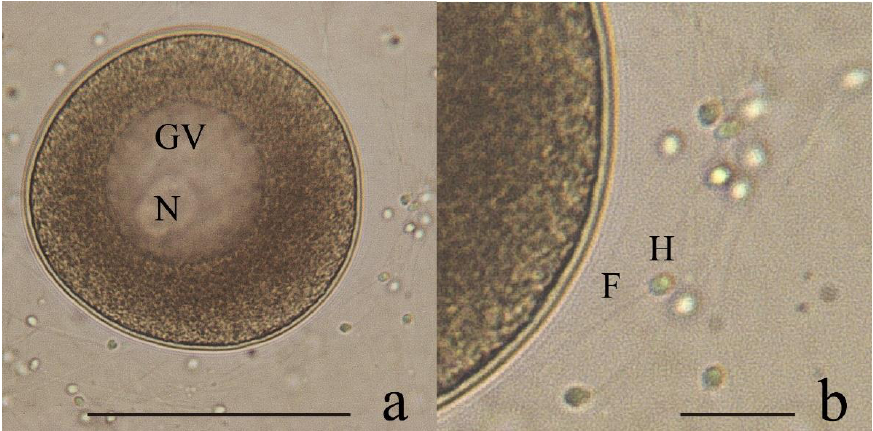
Figure 1. Oocyte and sperm of the surf clam Mesodesma donacium obtained by the stripping technique seen under a microscope. ( a ) Oocyte with germinal vesicle (GV) and nucleus (N), scale bar 50 μm; ( b ) sperm where the head (H) and flagellum (F) are observed (scale bar = 10 μm).